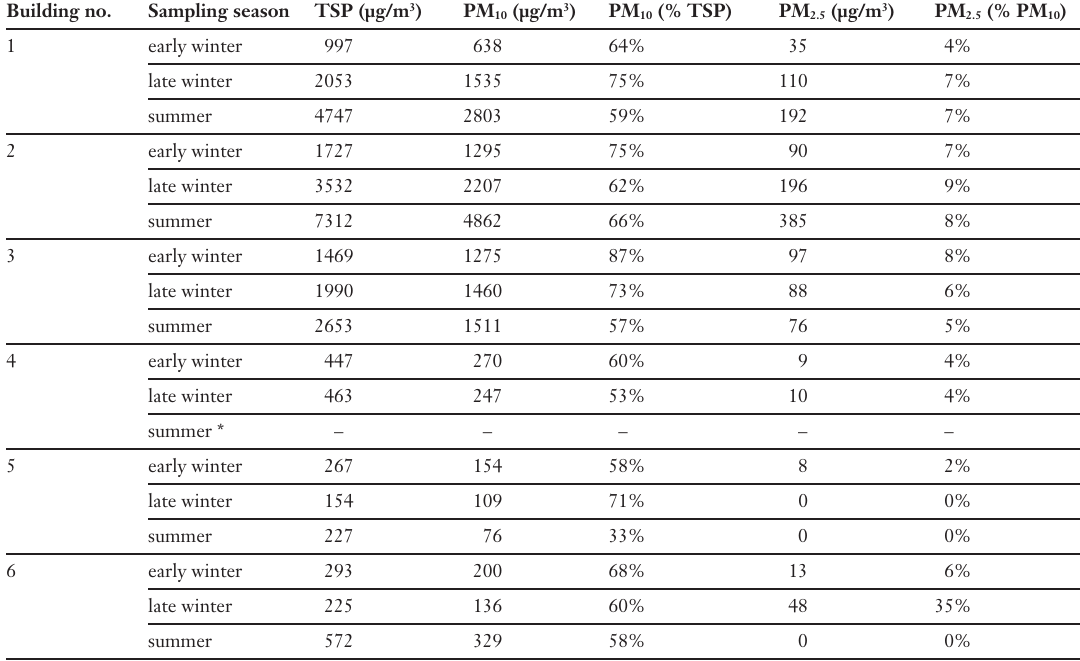
Table 2 Seasonal total (TSP) and respirable (PM 10 ) dust